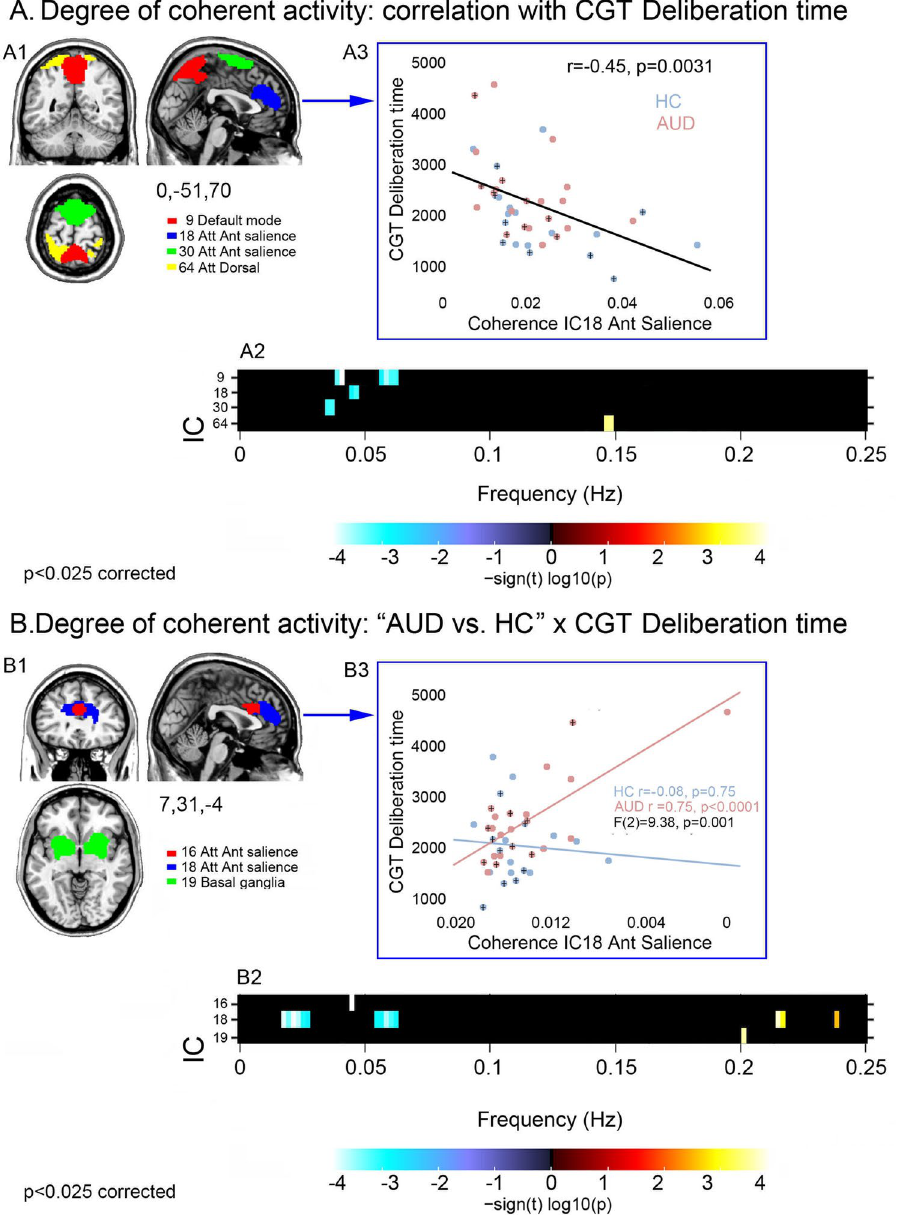
Figure 2. Coherence of intra-network activity: correlation with CGT decision latency in the whole sample and latency-by-group interaction. For the ICs showing a significant correlation with deliberation time (panel A1 ), or a latency-by-group interaction (panel B1 ), their direction and strength are depicted by the frequency bins reported in the respective panels A2 and B2 (p < 0.025 corrected). In the whole sample ( A2 ), the association between decision latency and coherence of intra-network activity involves either a negative correlation with high coherent activity (low frequency power; blue colour scale) (9,18,30), or a positive correlation with low coherent activity (high frequency power; red colour scale) (64). Latency-by-group interaction analyses ( B2 ) showed that the relationship with decision latency is stronger, in AUD patients vs. controls, in the same anterior salience network (16,18), as well as in the basal ganglia (19) networks. Scatterplots depict the relationship between decision latency and coherent activity in the anterior salience network, regardless of group (correlation analysis; A3 ) and specifically in AUD vs. controls (interaction analysis; B3 ). In the scatterplots, a “plus” (+) sign denotes female participants. Att Ant salience: anterior salience network; Att Dorsal: dorsal attentional